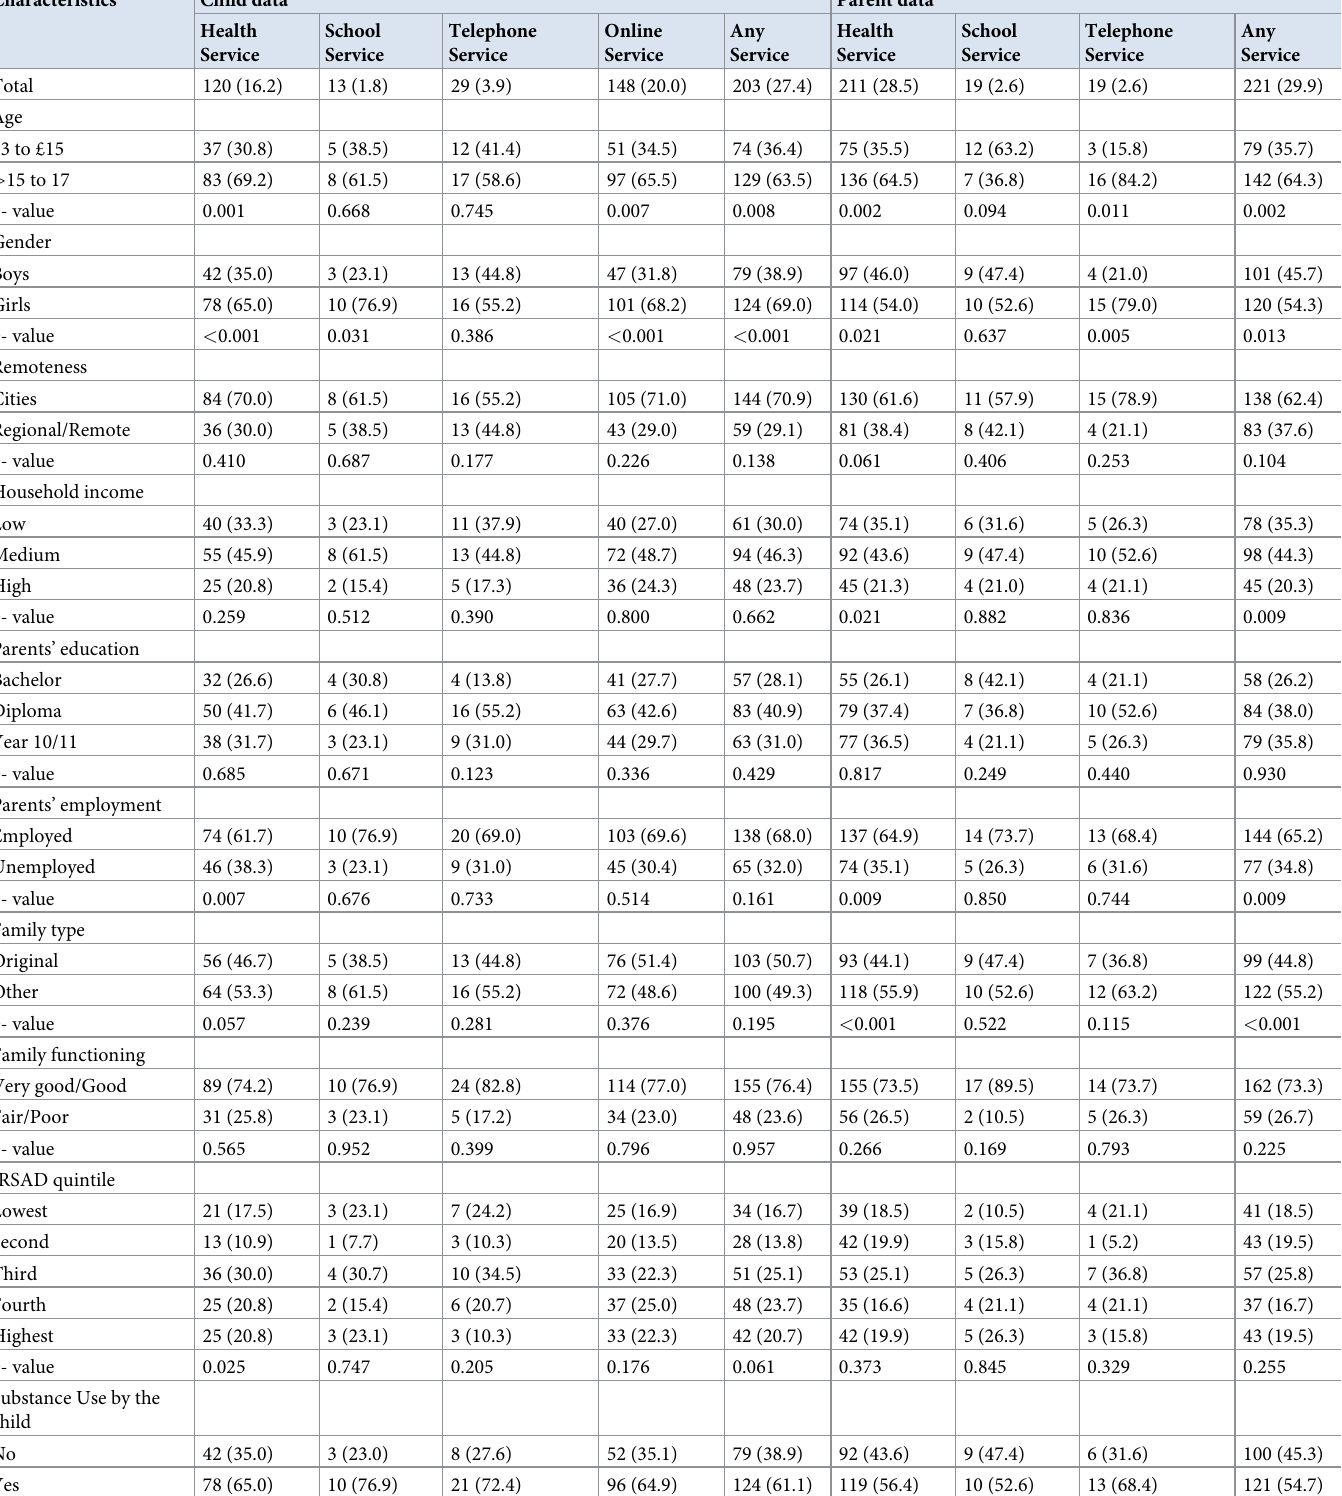
Table 2. Bivariate analysis between mental health services and sociodemographic factors in adolescents with mental disorders (n = 740).